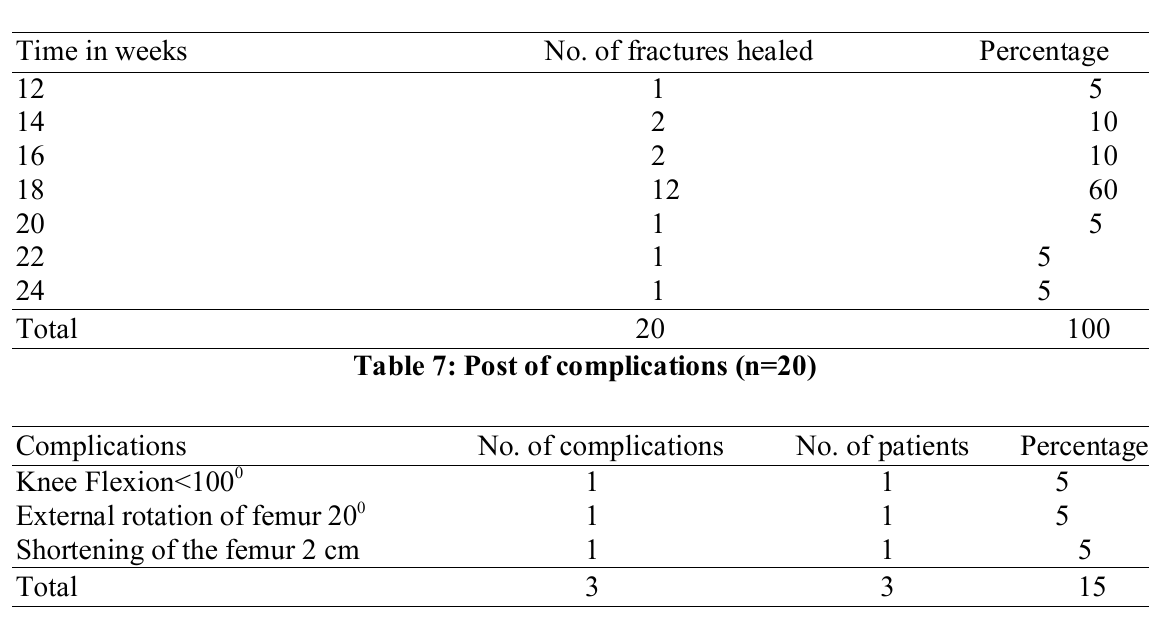
Table 6: Fractures healing time (n=20)